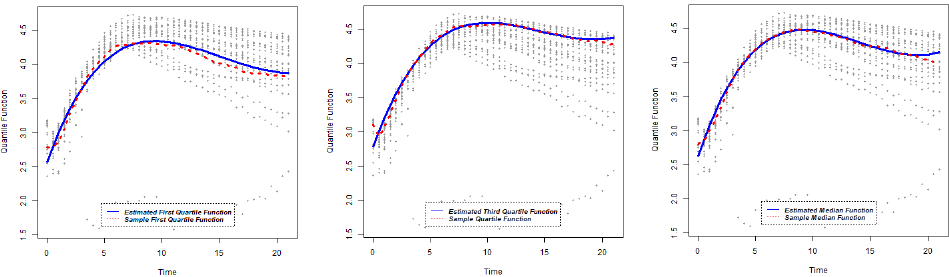
Figure 18. Quantile functions and sample quantile functions of PA0573(E6): lower quartile ( left ); median ( center ); upper quartile ( right ).